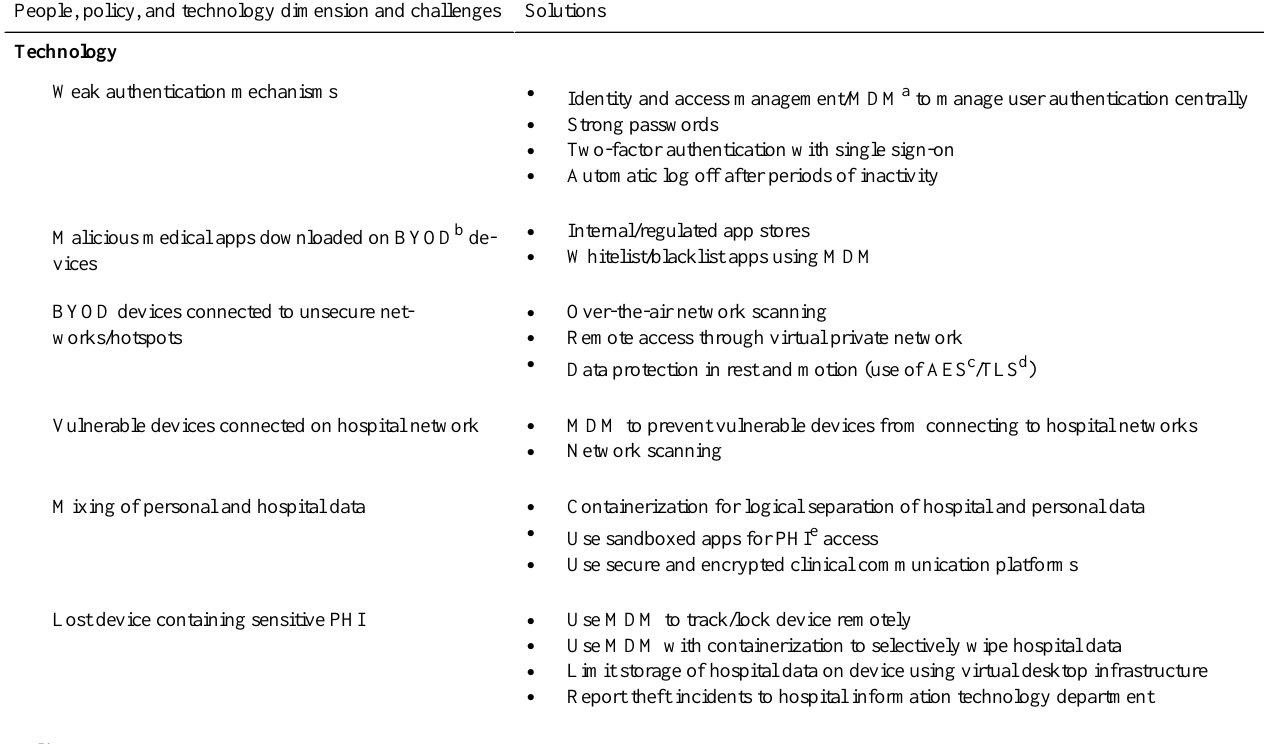
Table 3. Summary of hospital bring-your-own-device security challenges and